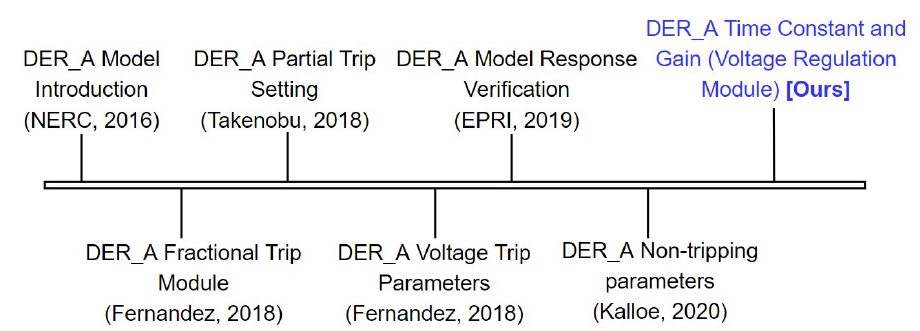
Figure 1. Comparison of DER_A parameter calibration in the literature [15–20] and our pro- posed